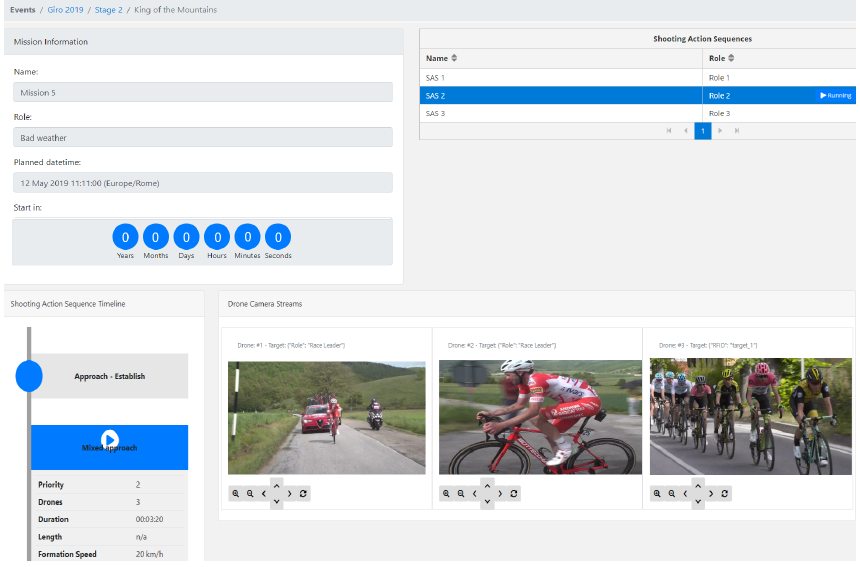
Figure 7. Example screenshots of the three tabs of the shooting action configuration page. From top to bottom: main data, drone formation data, and shooting role data.